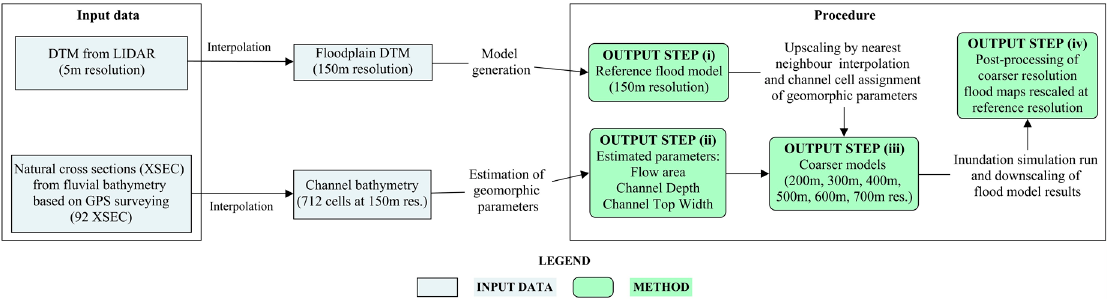
Figure 3. Flow chart describing the procedure implemented for interpolating the fluvial bathymetry and resampling floodplain terrain data to support coarse resolution flood modeling.